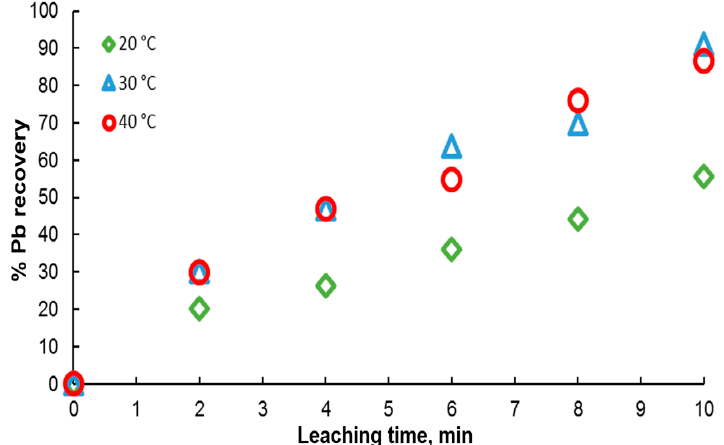
Figure 7. Effect of temperature on lead dissolution from pure galena. Experimental conditions: particle size: − 149/+74.1 g of mineral, 0.1 L of solution, 0.3 M Na 3 Cit, 0.6 M H 2 O 2 .